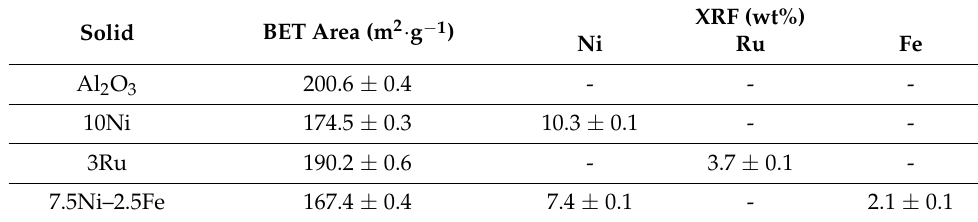
Table 1. Surface area (BET) and chemical composition (XRF) of the solids.